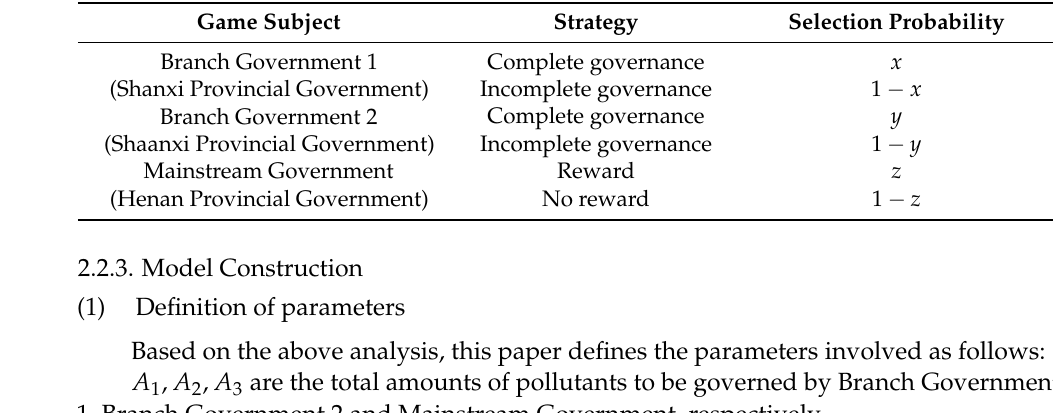
Table 1. Three-way game